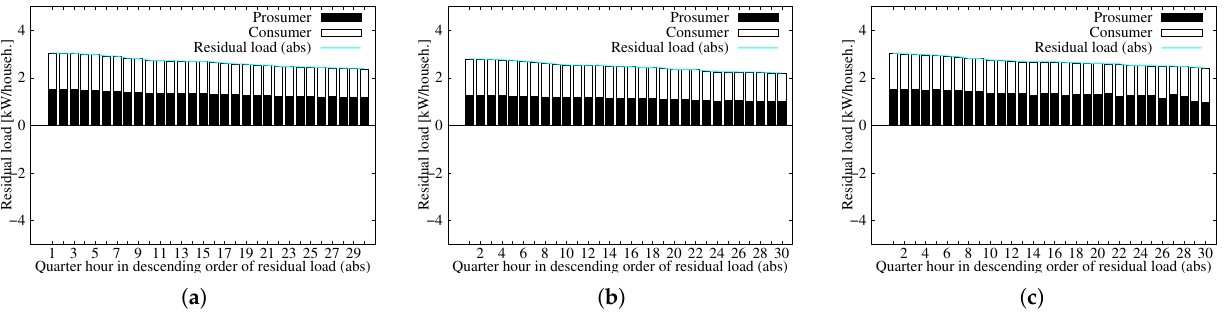
Figure 9. Residual loads at the node, per household [kW] and in descending order of the absolute value of the residual load. All figures are for a distribution network of n = 49 households, i.e., σ = 7. For a 50% prosumer penetration ratio under consideration of widespread e-mobility. ( a ) Battery mode 1, with e-mobility; ( b ) Battery mode 2, with e-mobility; ( c ) Battery mode 3, with